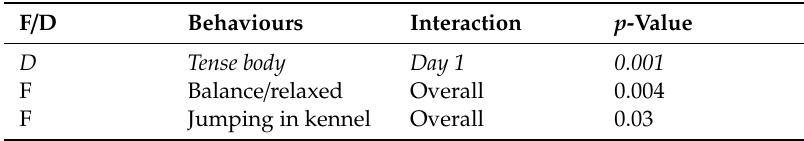
Figure 5. The frequency of behaviours over the first five days that adopted or euthanased dogs ( n = 38) spent in a shelter. Table 4. Differences in kennel behaviour between dogs that were euthanased and adopted, either overall or on certain days.